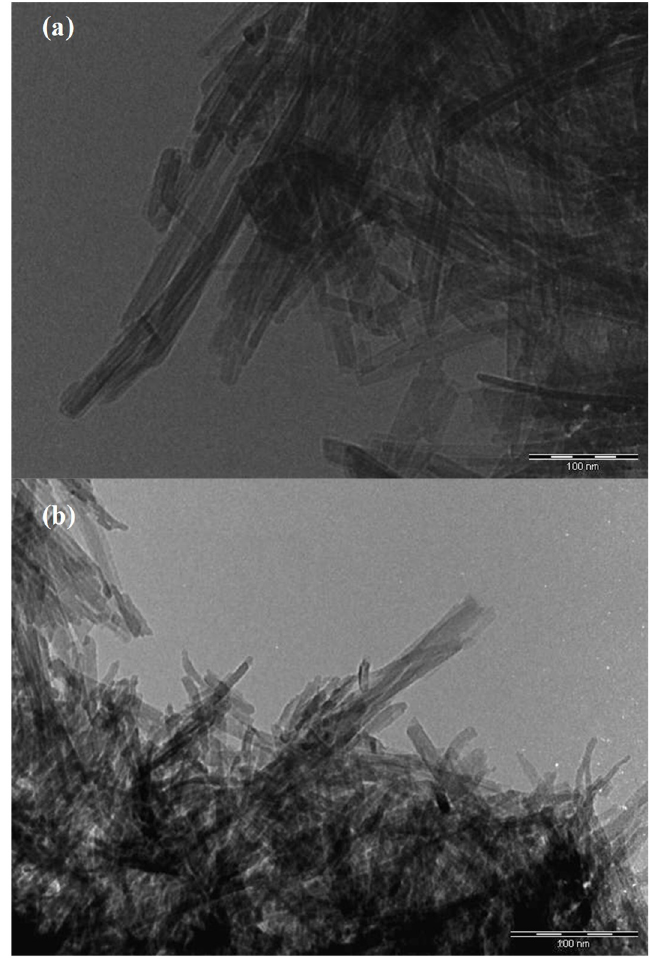
Figure 7. TEM images of natural ( a ) and modified with CTAB ( b ) sepiolite, respectively.